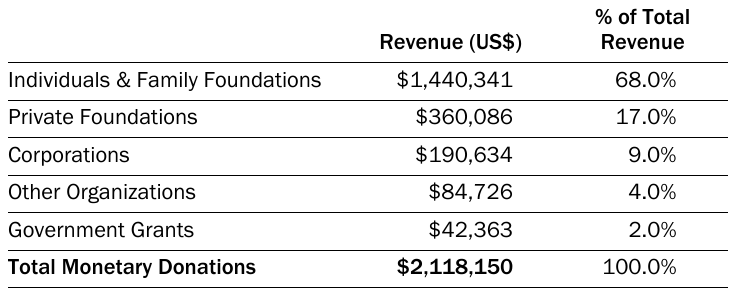
Table 3. The Food Project’s Monetary Donations (in US$) by